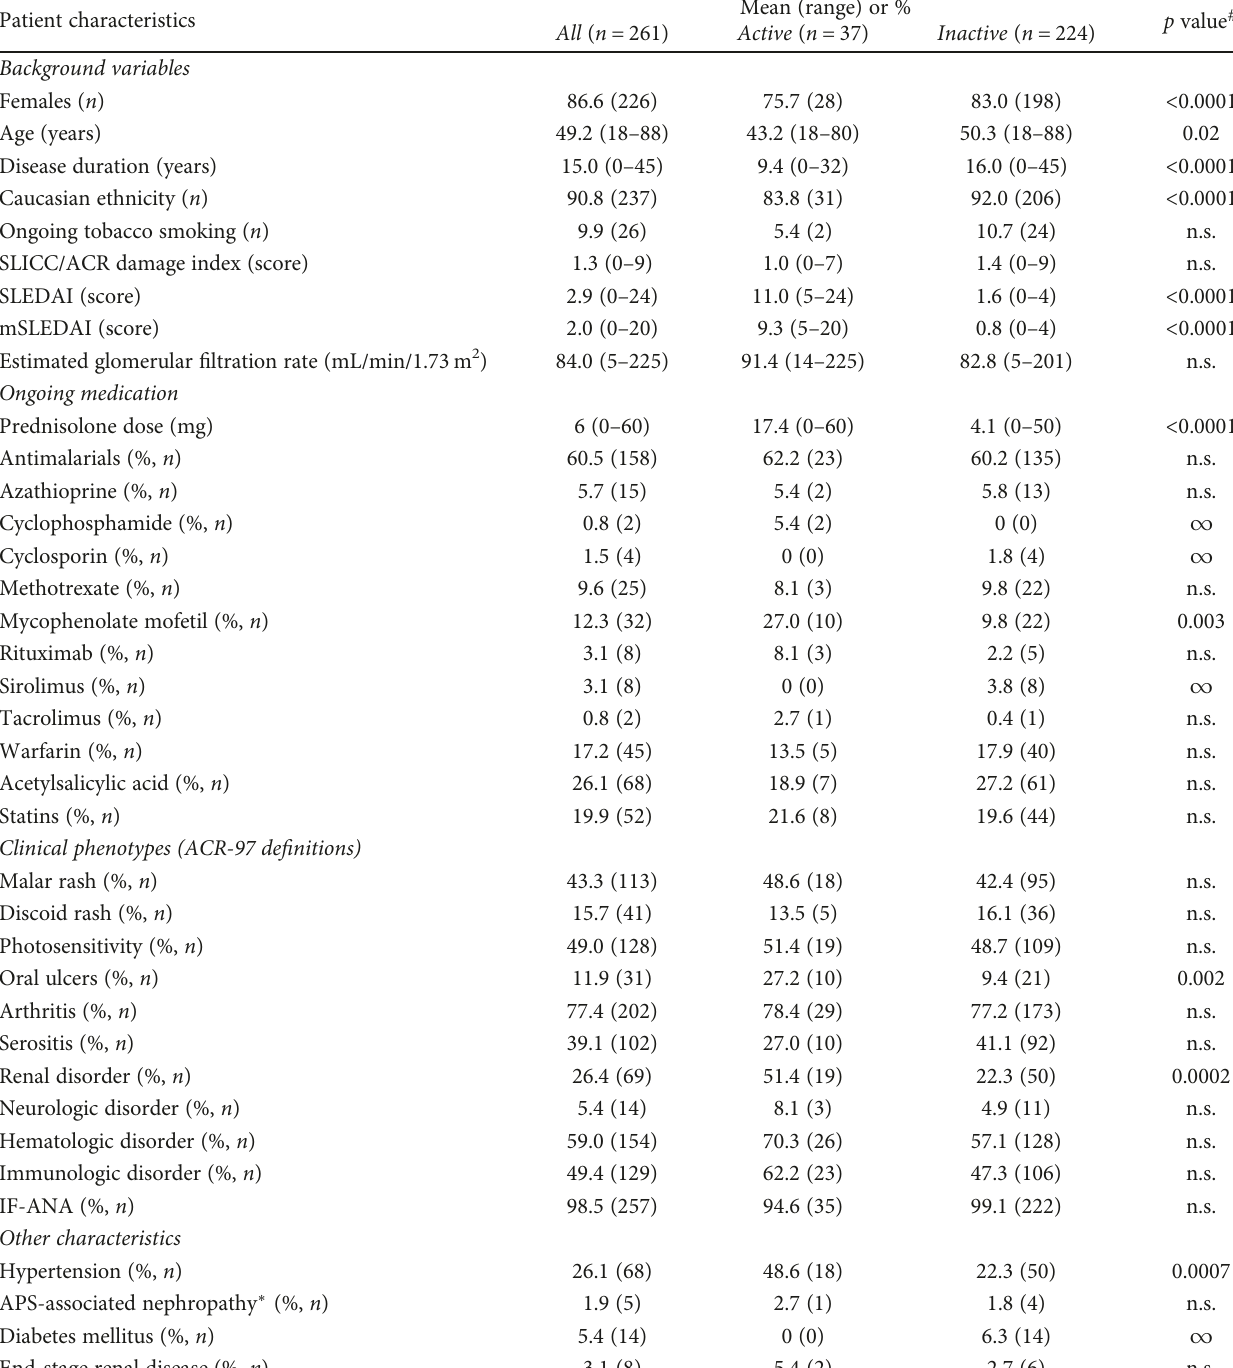
Table 1: Detailed characteristics of the 261 SLE patients in relation to disease